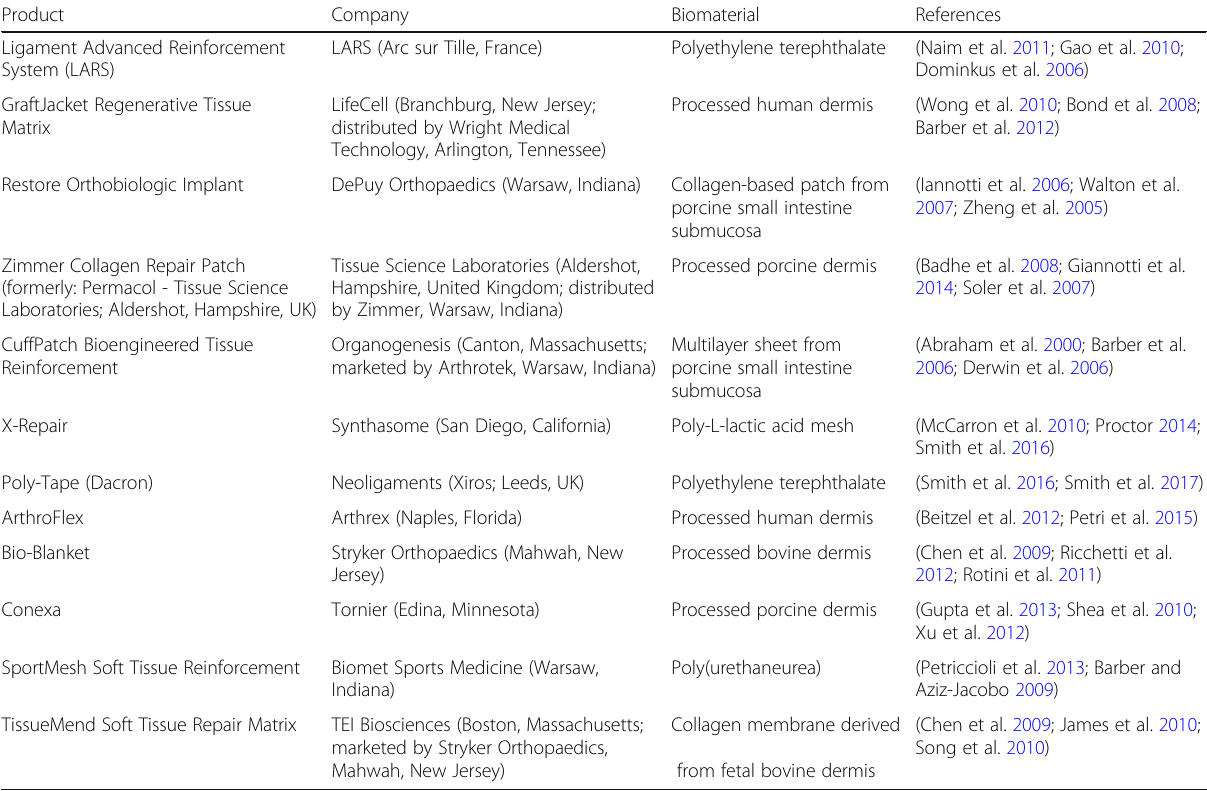
Table 1 Examples of commercial products for tendon